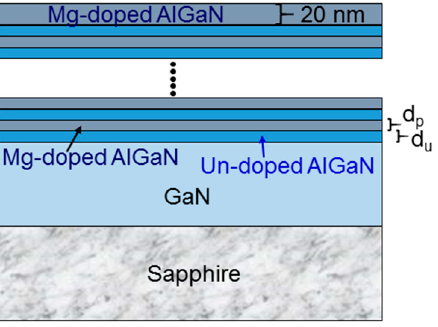
Figure 1. Schematic illustration of the structure of an Mg-doped/un-doped AlGaN layer-structured sample.